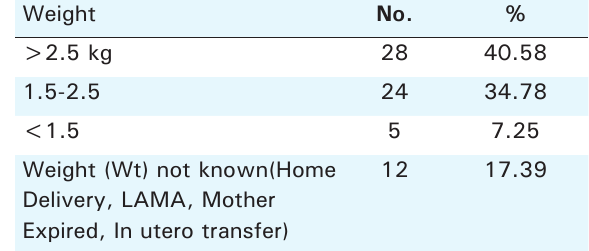
Table 8. Fetal Outcome